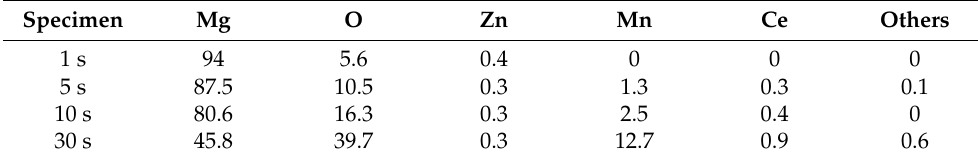
Table 2. Results for EDS for LZ91 Mg alloy after conversion coating treatment. Specimen